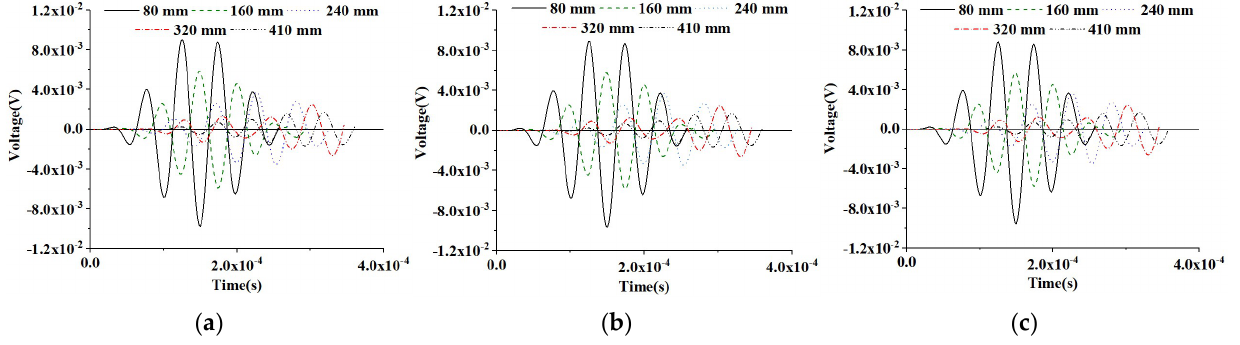
Figure 12. Response of sensors at different measurement distances from the actuator under a modulated sinusoidal excitation signal for healthy CHFEMs using different RAE dimensions: ( a ) 20 mm; ( b ) 25 mm; ( c ) 40 mm.